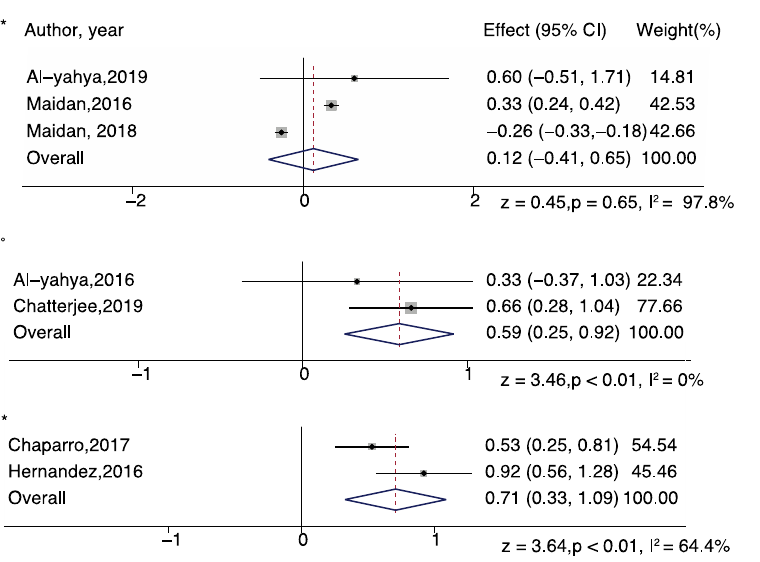
Figure 5. Dual task brain activation differences while doing serial subtraction tasks in healthy young adults ( A ), and in serial subtraction tasks ( B ), letter generation tasks ( C ), and obstacle walking tasks ( D ) in healthy older adults. Note: ◦ represents Fixed plot meta-analysis, * represents Random plot meta-analysis [29–31,35,36,44,47,48,52,62].